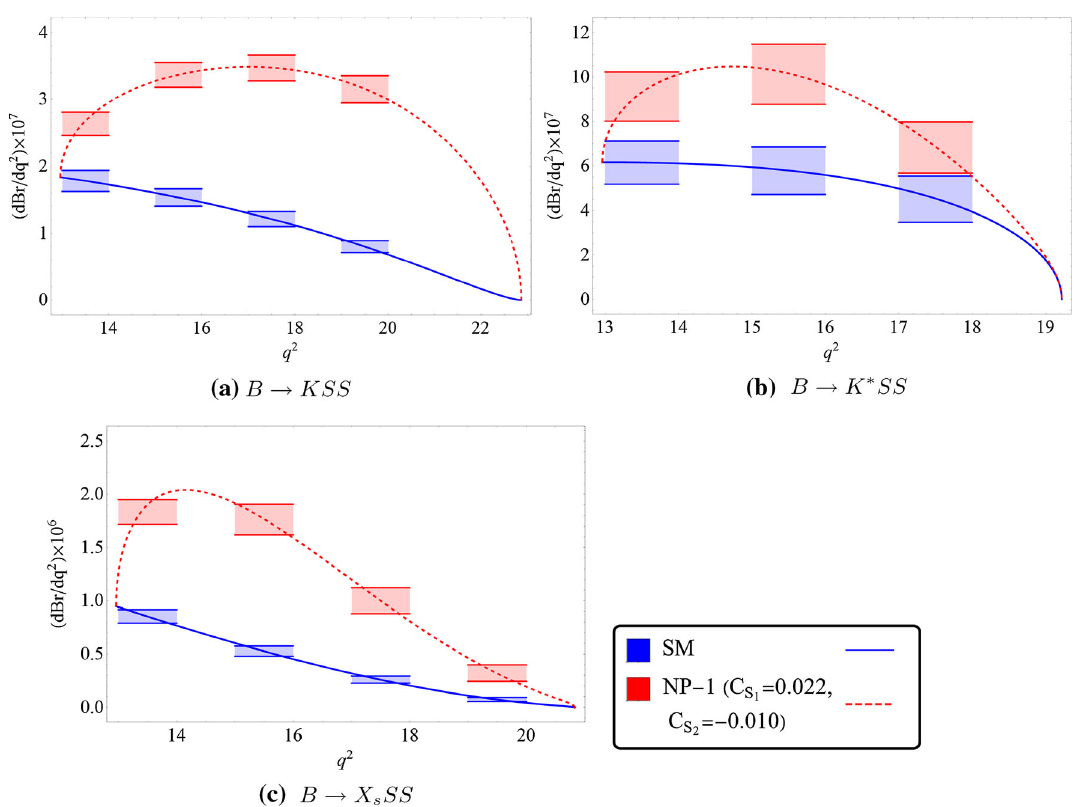
Fig. 8 Same as Fig. 6 with m S = 1 . 8 GeV